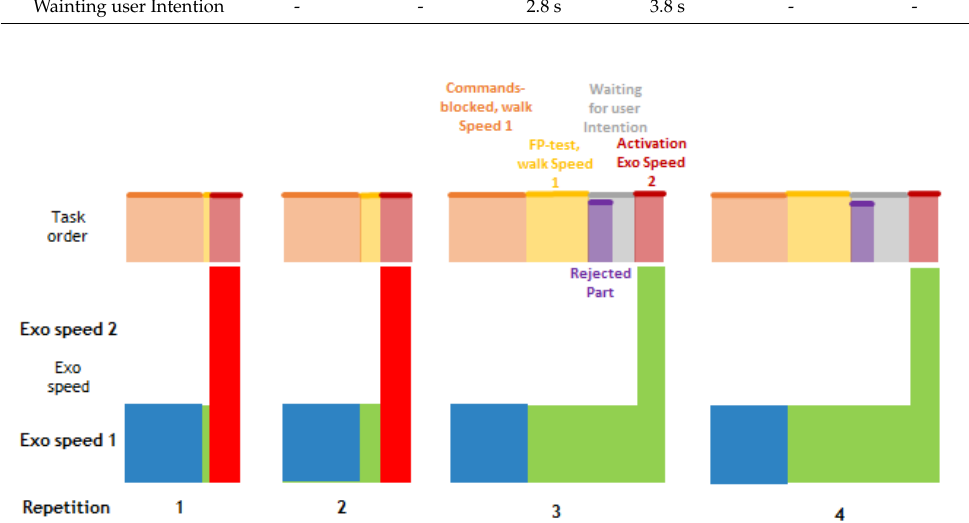
Figure 6. Repetitions 1, 2, 3 and 4 activation schema for the subject 4 at the E2 in the closed-loop test. Repetitions 5 and 6 were similar to 1 and 2 repetitions. At the top of the image the order of the tasks in color code as specified in Figure 2b). At the bottom of the image the activation pattern of the exoskeleton. In blue the speed 1 stage where the BMI cannot send commands. In green the correct speed phase (TP) and in red if it should not be activated as established